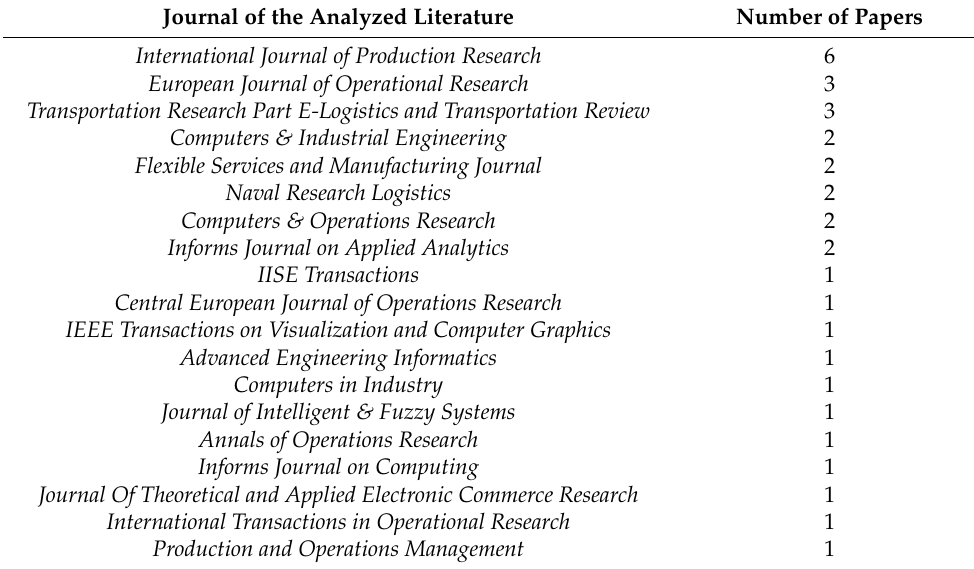
Table 2. Summary of the journals of the analyzed